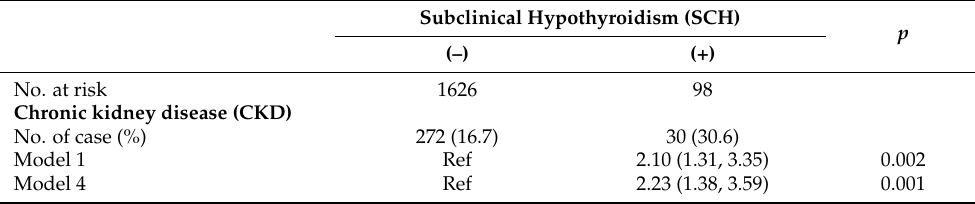
Table 3. Association between FT3/FT4 and chronic kidney disease (CKD), subclinical hypothy- roidism (SCH). FT3/FT4 Levels (Tertile) FT3/FT4Low Middle High